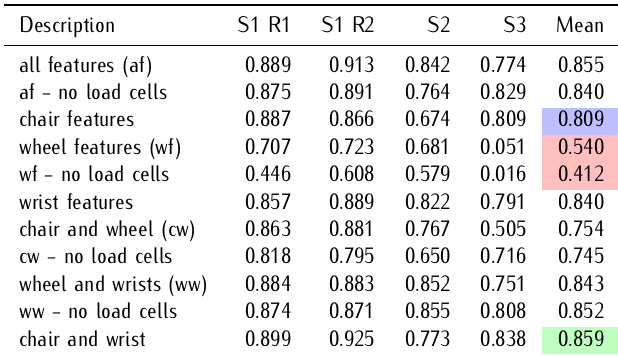
Table 6. Performance ( R 2 ) of the models built with different combinations of